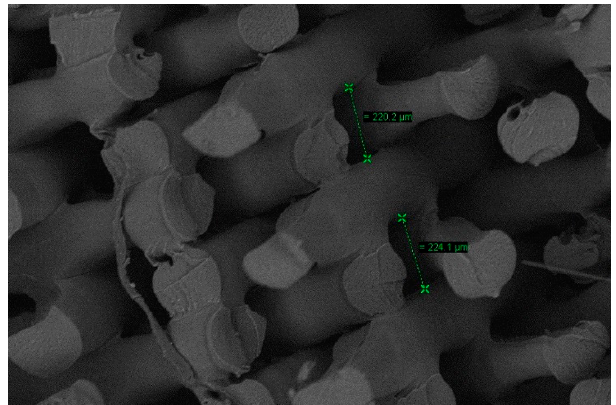
Figure 11. Rectilinear pattern.